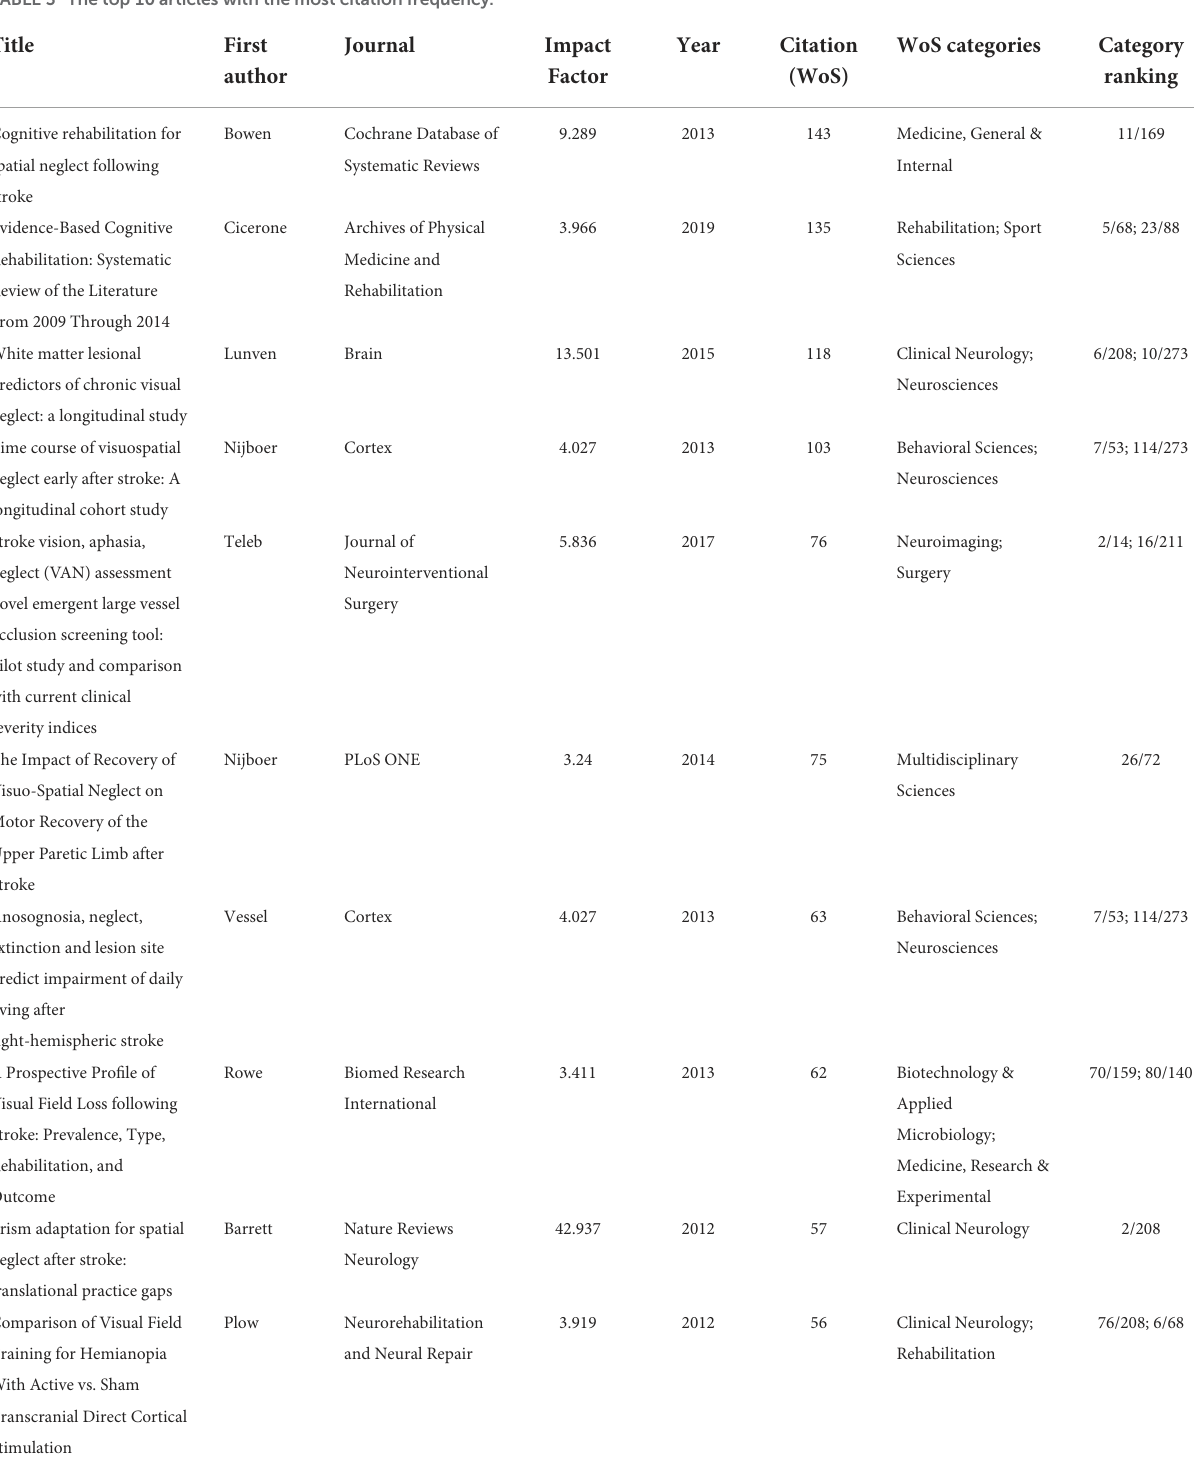
TABLE 3 The top 10 articles with the most citation